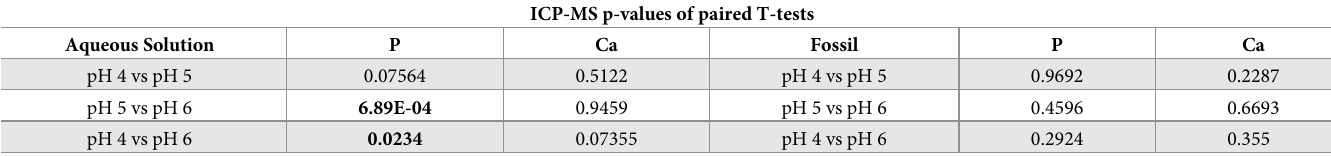
Table 5. Paired T-test results of changes in phosphorus (P) and calcium (Ca) concentrations for aqueous solutions and fossils. ICP-MS p-values of paired